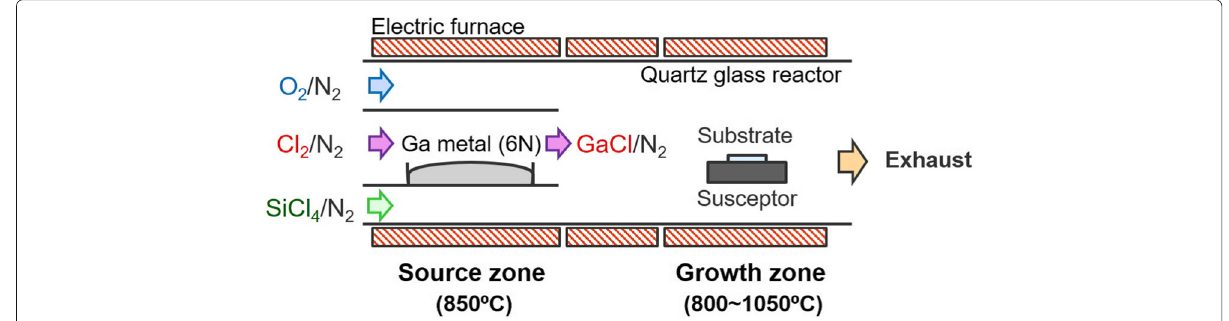
Fig. 5 Schematic of HVPE reactor for β -Ga 2 O 3 epitaxial